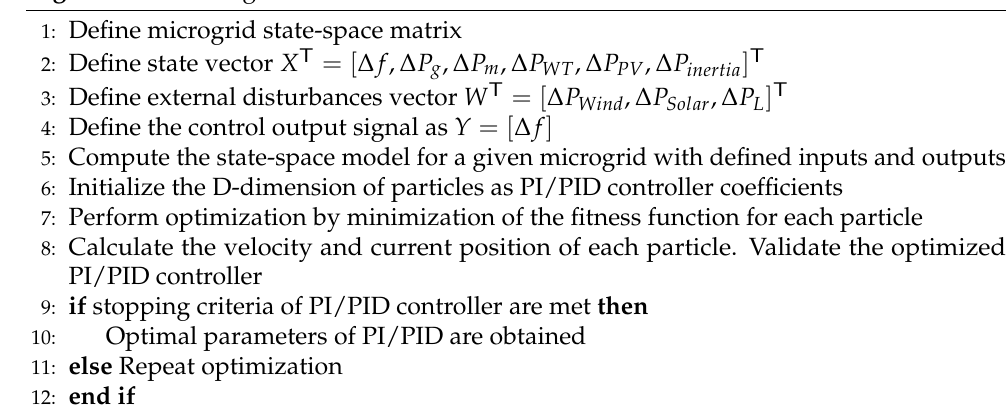
Algorithm 4 PSO